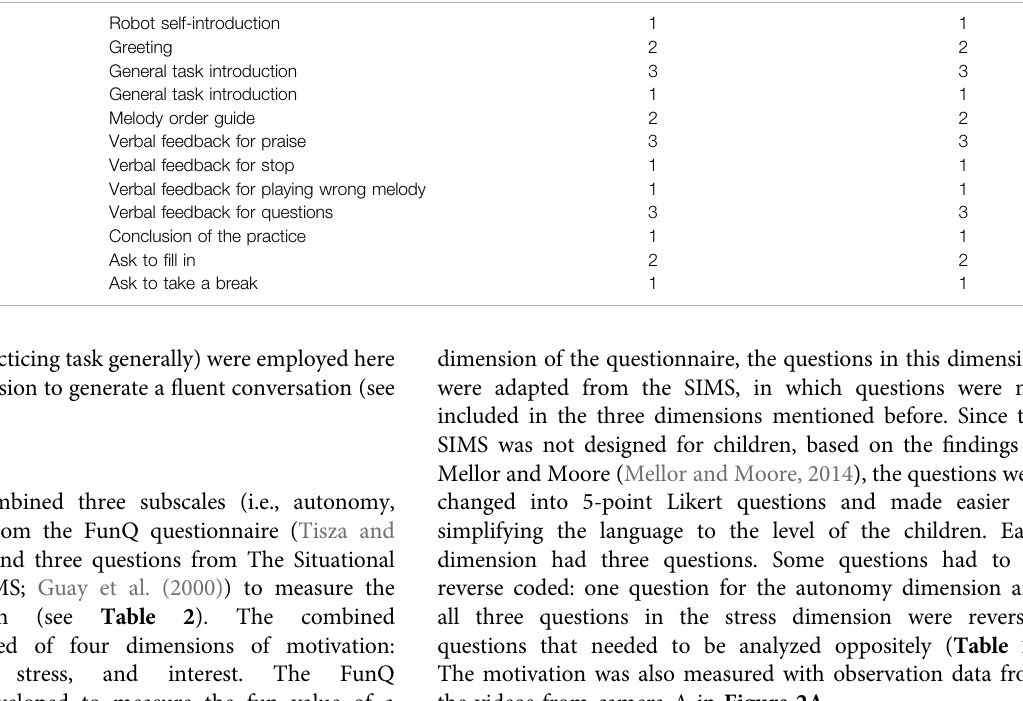
TABLE 1 | Numbers of robot behaviors for evaluative role and nonevaluative role in different tasks. Context Tasks Evaluative robot Nonevaluative